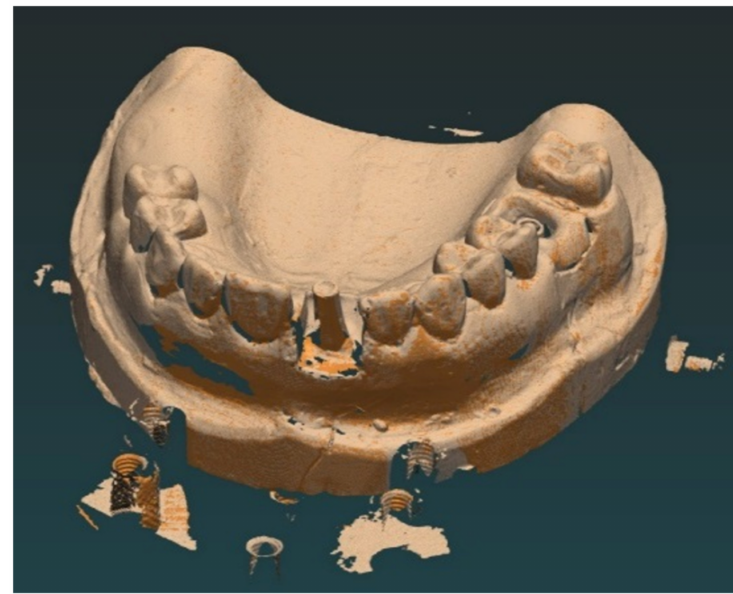
Figure 2. Scanned dental cast of the prepared stock